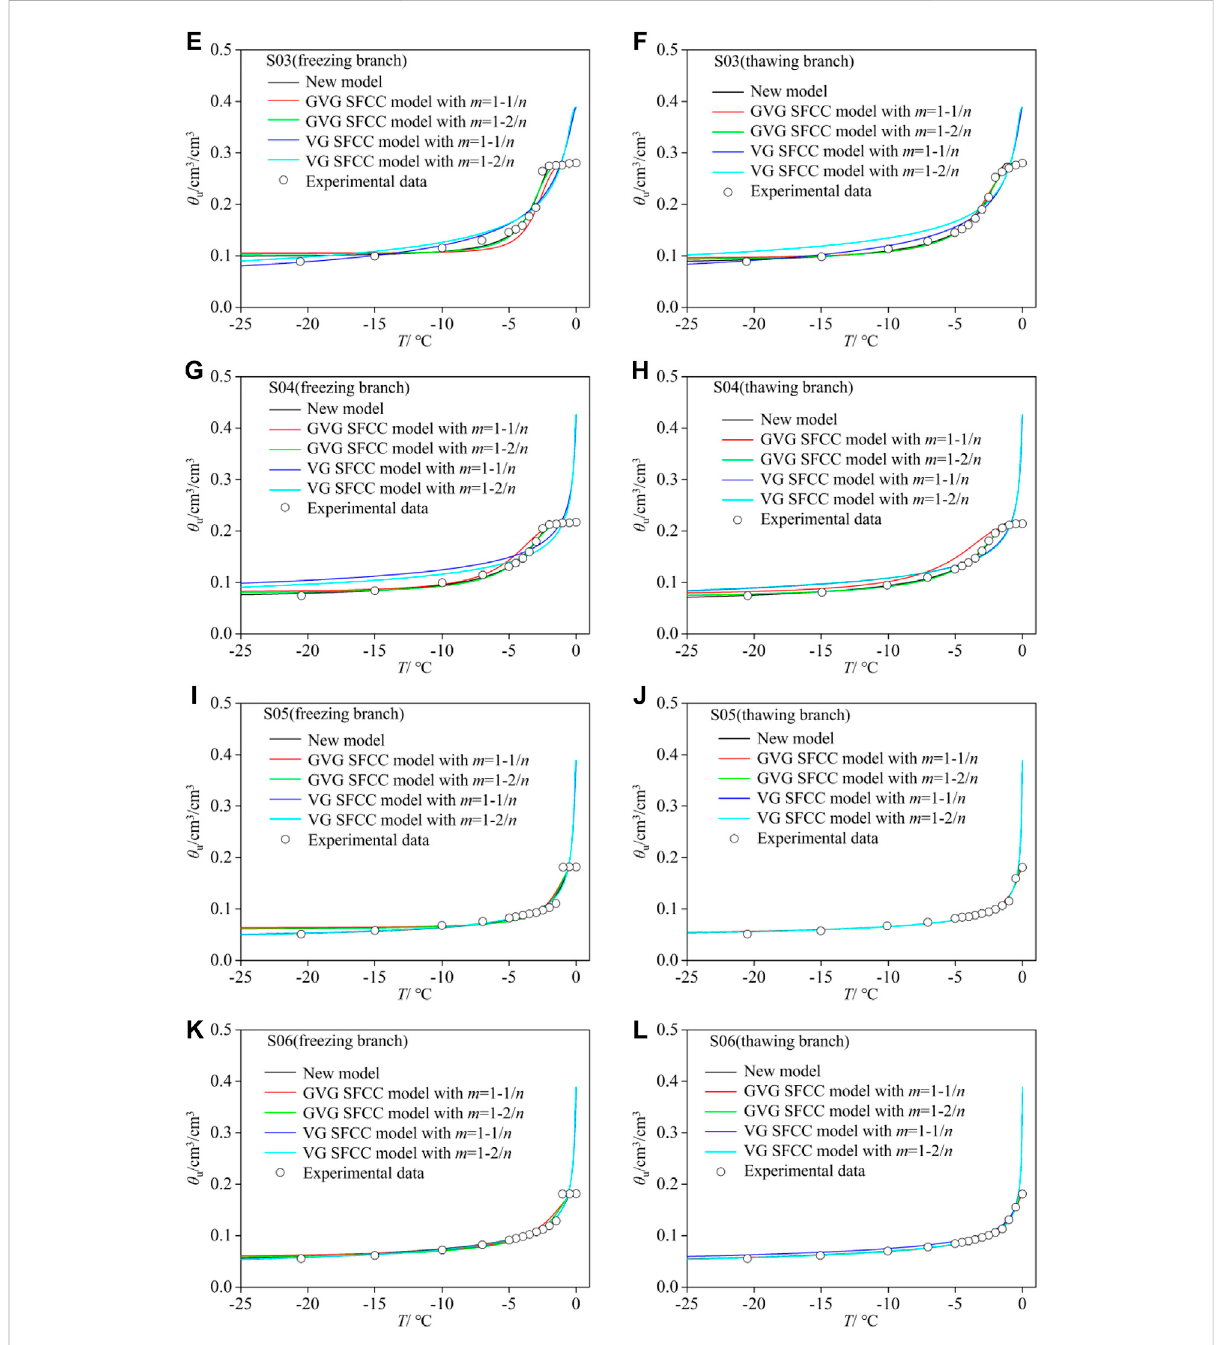
Table 4, the positive AD values revealed that the new model, VG SFCC model with m =1-1/ n , and VG SFCC model with m =1-2/ n usually overestimated the SFCC, and the negative AD